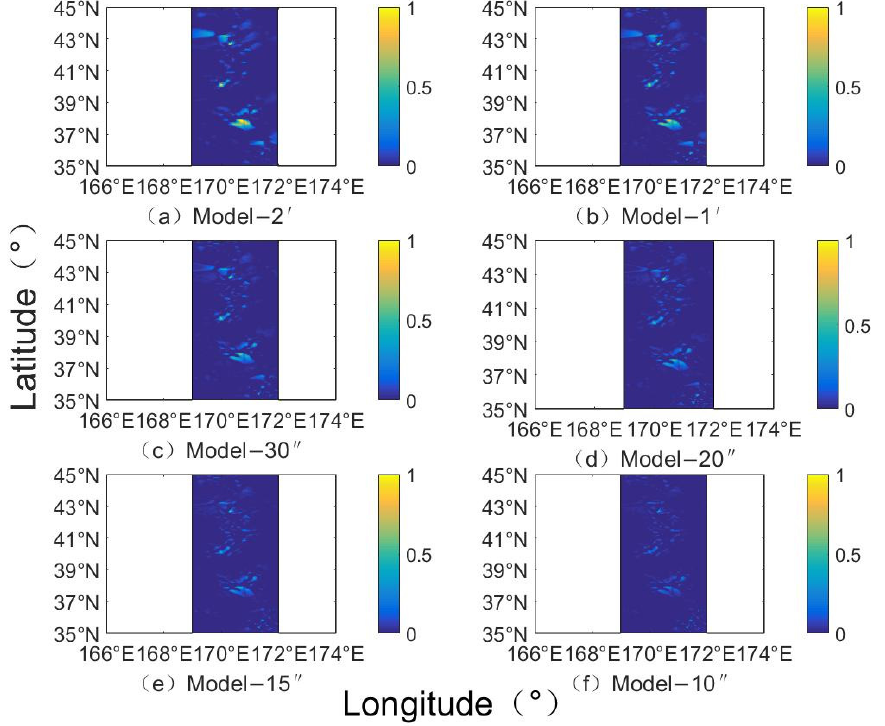
Figure 9. The relative error distribution of the Emperor Seamount Chain seafloor topography between different resolution inversion models and bathymetry grid model.